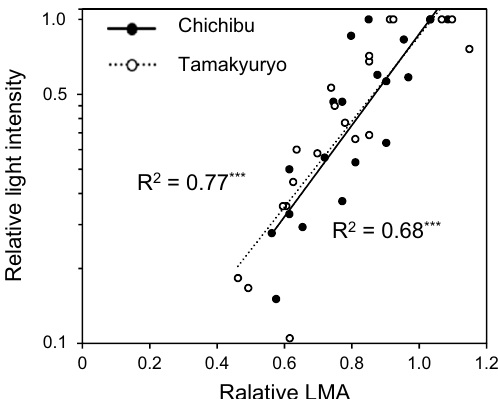
Figure 6. The relationship between relative LMA and relative light intensity in a canopy of Q. serrata grown in FM Tamakyuryo (while circle) and FM Chichibu in 2018 (black circle) (n = 20). Dotted and solid lines indicate regression line of FM Tamakyuryo and FM Chichibu, respectively. Y-axis was transformed into log-scale. In x-axis, higher relative LMA indicates upper canopy and lower relative LMA indicates lower canopy. *** p <